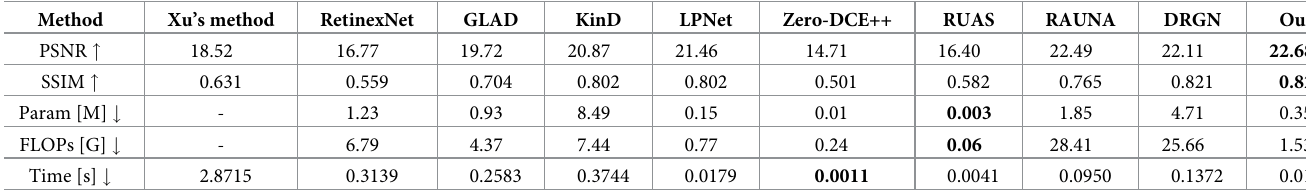
Table 1. Quantitative comparison on LOL